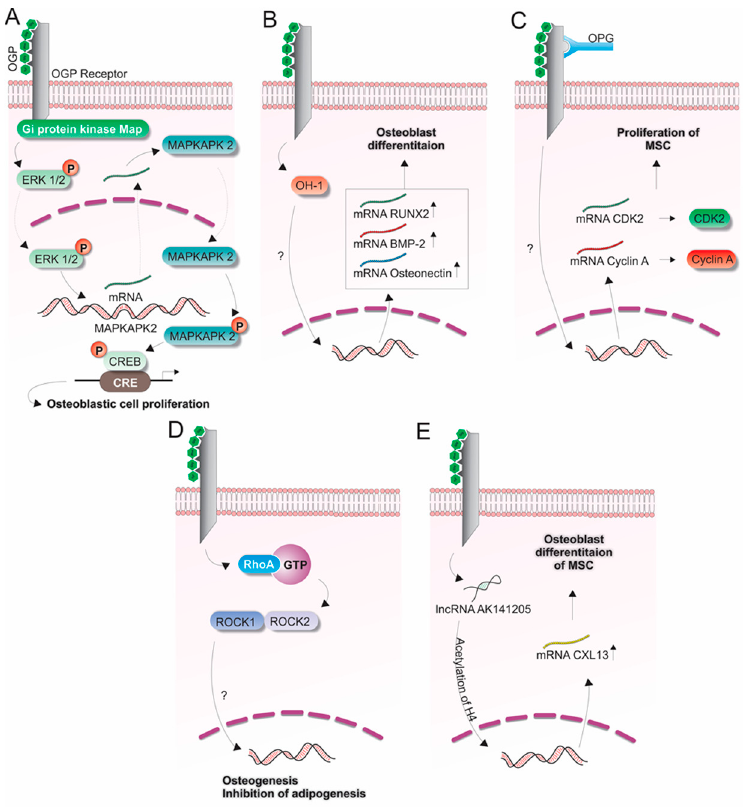
Figure 2. Signaling pathways potentially associated with OGP(10–14) (in green) during the bone formation process. ( A ) Proliferation of osteoblastic cells (MC3T3-E1) induced by OGP involving the ERK1/2, MAPKAPK2, CREB signaling cascade [58]; ( B – D ) Differentiation of mesenchymal stem cells (MSCs) to osteoblasts by linking the OGP(10–14) to its cellular receptor. ( B ) Participation of heme oxidase 1 (HO-1), Osteonectin, BMP-2 and RUNX-2 [56]; ( C ) Extracellular osteoprotegerin (OPG) influencing the cytoplasmic expression of Cyclin A and CDK2 [55]; ( D ) RhoA/ROCK signaling cascade in the presence of GTP [57]; ( E ) Participation of lncRNA AK141205 in the acetylation of H4 influencing the expression of CXCL13 in osteoblast differentiation [60].